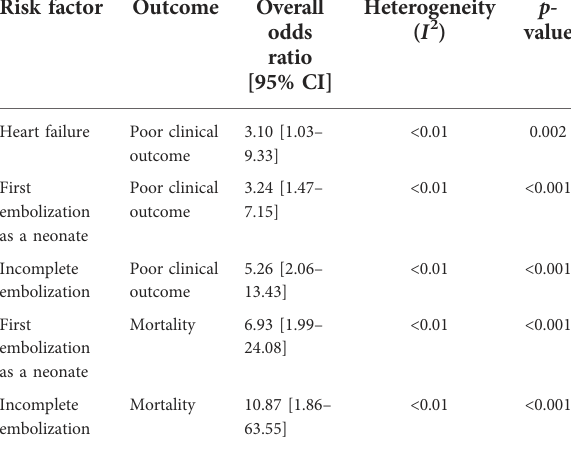
TABLE 2 Overall endovascular embolization